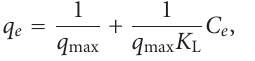
percent extraction. It is clear from the data listed in Table 3 that a 100.0% extraction of Pb(II) by Ox-AC and